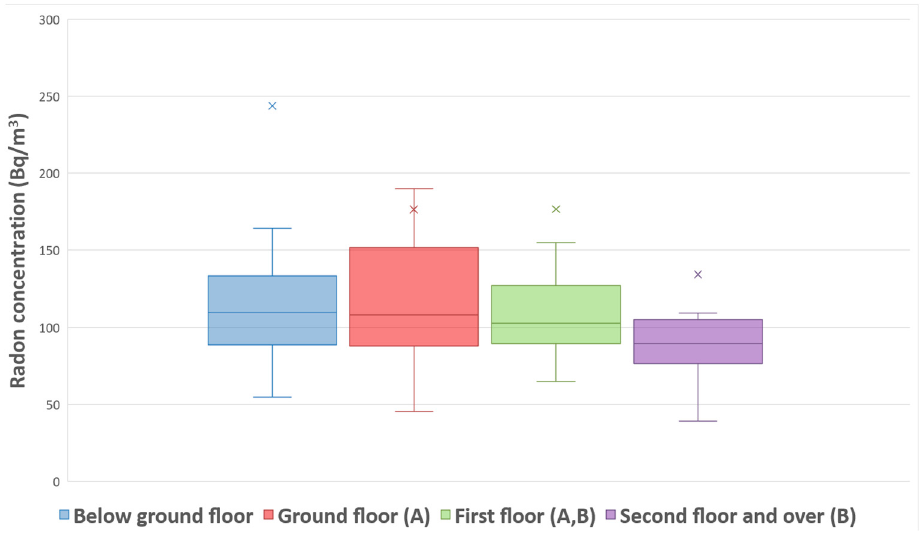
Figure 4. Box plot of annual radon activity concentrations per floor level without outliers for a better visual. The x symbol represents the AM. Floors share the same uppercase letter in brackets if the corresponding distributions of annual radon activity concentration value have statistically significant differences ( p ≤ 0.05): (A) W-test p = 0.043; (B) W-test p = 0.046.